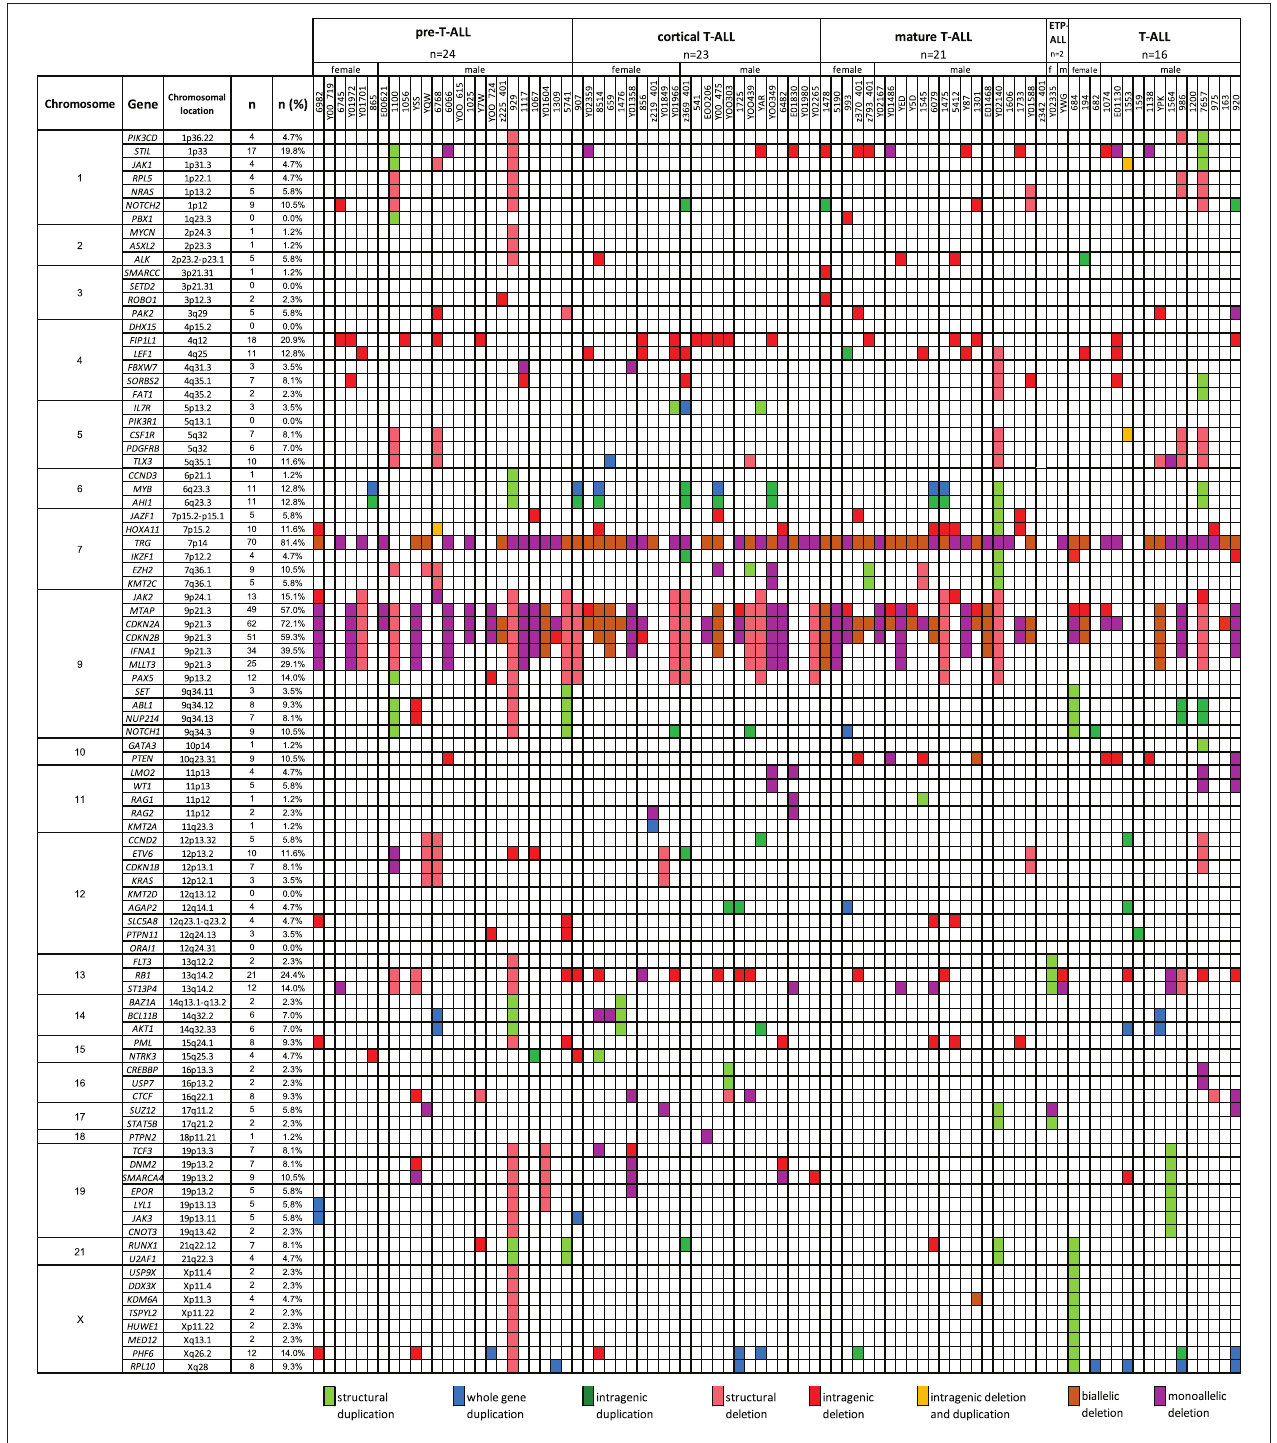
FIGURE 5 | The frequencies of CNAs of all 92 selected genes in 86 T-ALL cases according to particular chromosomes. Moreover, monoallelic intragenic deletions involving the region from exon 16 to exon 22 of gene SORBS2 were found in five cases. Monoallelic intragenic deletions covering the last exon of